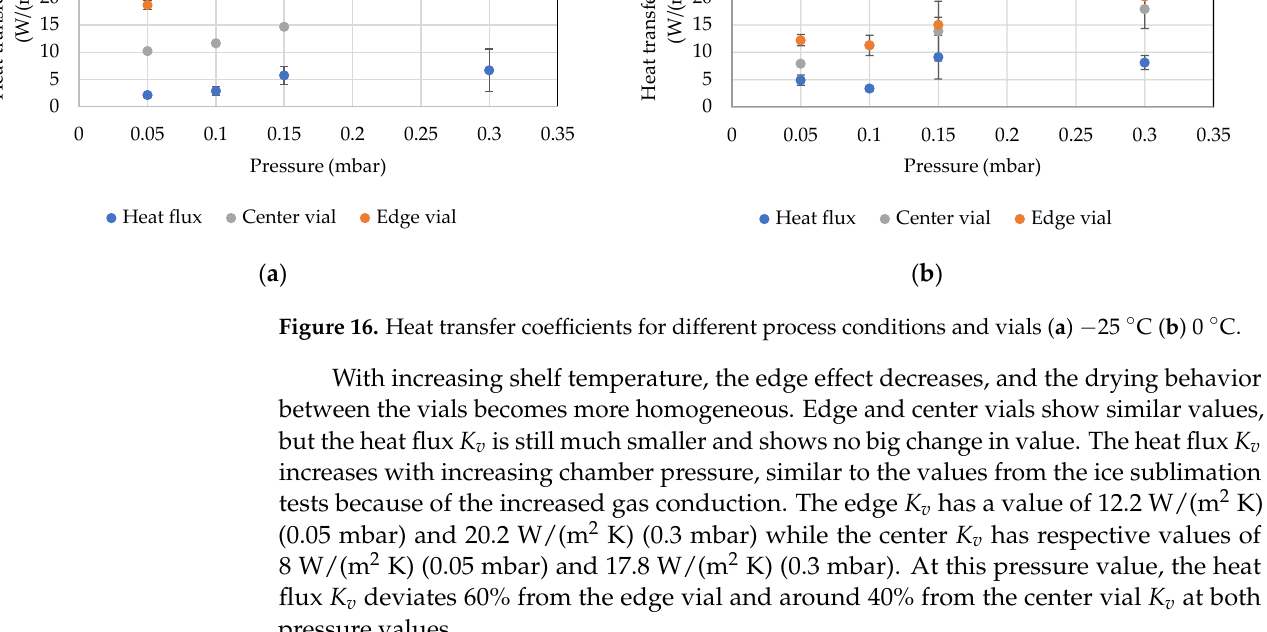
(0.05 mbar) and 20.2 W/(m 2 K) (0.3 mbar) while the center K v has respective values of 8 W/(m 2 K) (0.05 mbar) and 17.8 W/(m 2 K) (0.3 mbar). At this pressure value, the heat flux K v deviates 60% from the edge vial and around 40% from the center vial K v at